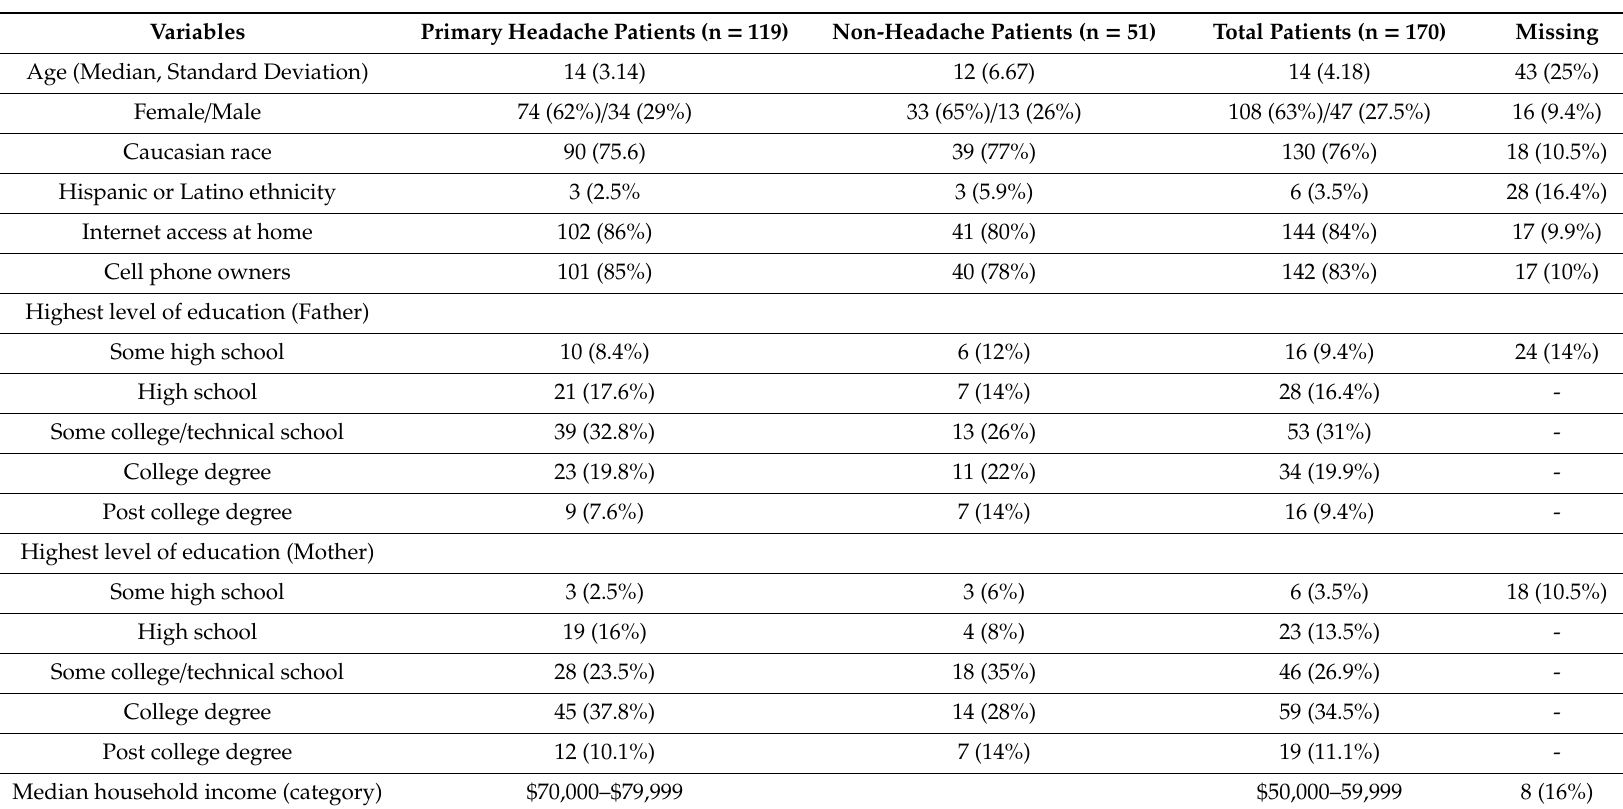
Table 1. Demographic information for all respondents and for those who indicated headache as the primary reason for their clinic visit.